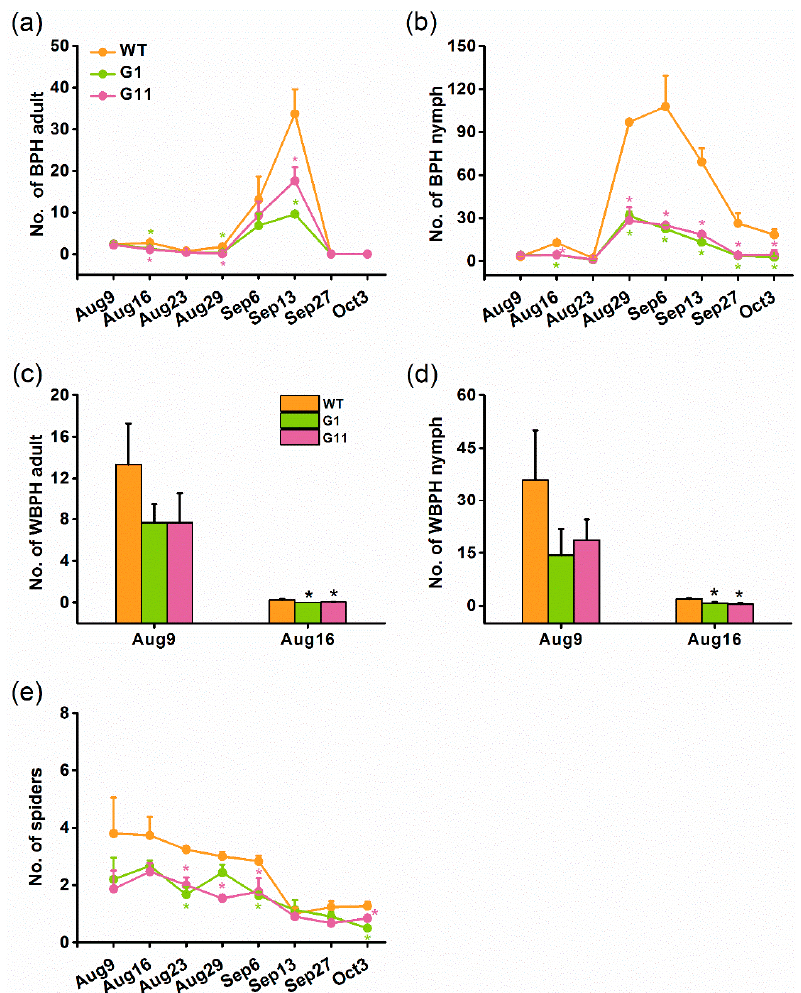
Figure 6. Population dynamics of brown planthopper (BPH), white-backed planthopper (WBPH), and spiders on oe-GID and WT plants in the field. Mean number (+SE, n = 3) of BPH adults ( a ), BPH nymphs ( b ), WBPH adults ( c ), WBPH nymphs ( d ), and spiders ( e ) per hill on G1, G11, and WT plants. Asterisks indicate significant differences in oe-GID1 plants, compared with WT plants (Duncan’s multiple range test; * p < 0.05).